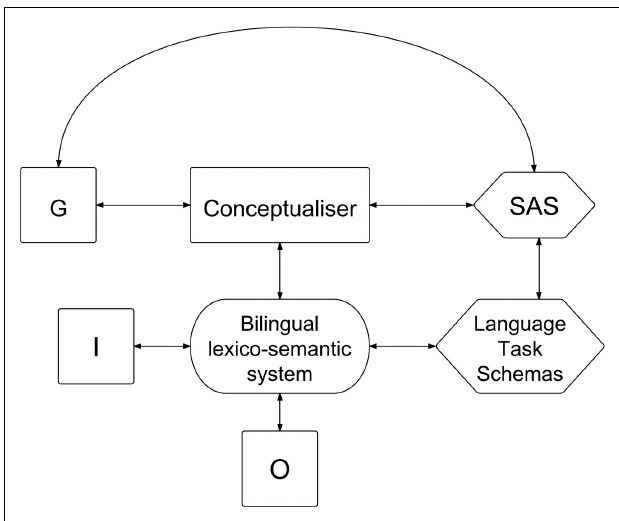
FIGURE 1 | Inhibitory control (IC) model of bilingual language production (Green,